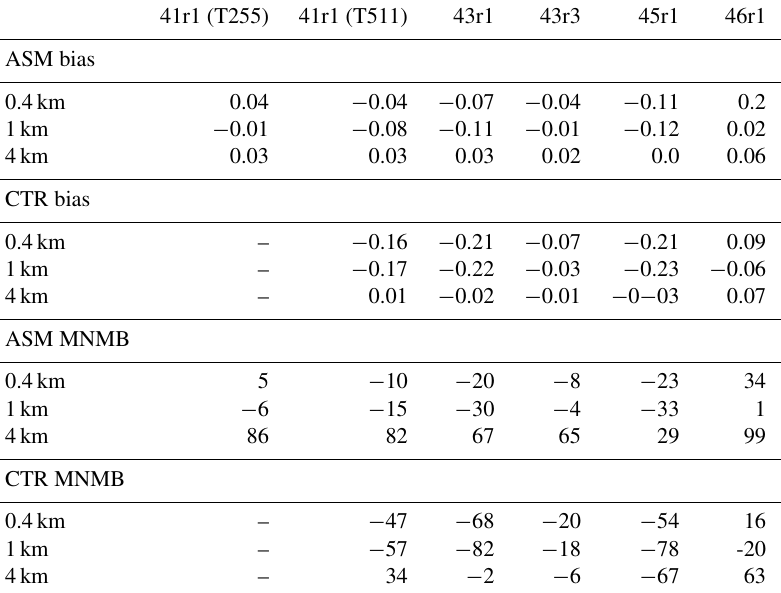
Table 2. Bias [Mm − 1 sr − 1 ] and MNMB [%] of β ∗ (z) for ASM and CTR runs at 0.4, 1 and 4km altitude above-ground averages within the different model configurations of Table 1.